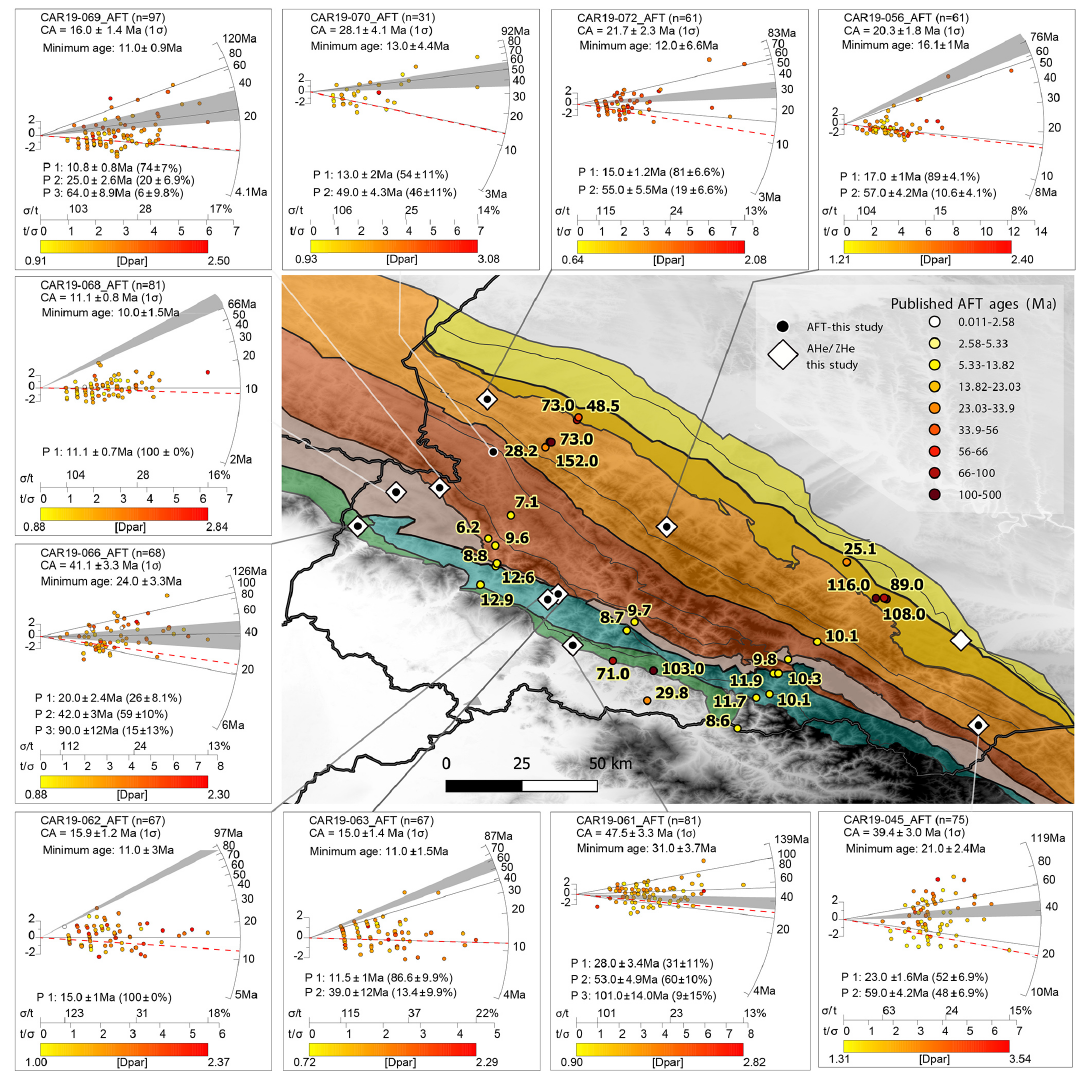
Figure 3. AFT data from this study shown as radial plots (centered on the central age, which is reported below the sample code as CA); individual single-grain ages in radial plots are colored according to Dpar value. A grey band in the radial plots indicates depositional age, and thin black lines are different age populations (P1, P2, etc.); the red dashed line is minimum age. Colored circles on the map show AFT central ages from previous studies (Nakapelyukh et al., 2017, 2018; Andreucci et al., 2013, 2015). The base map shows the different nappes, with the color scheme as in Fig.